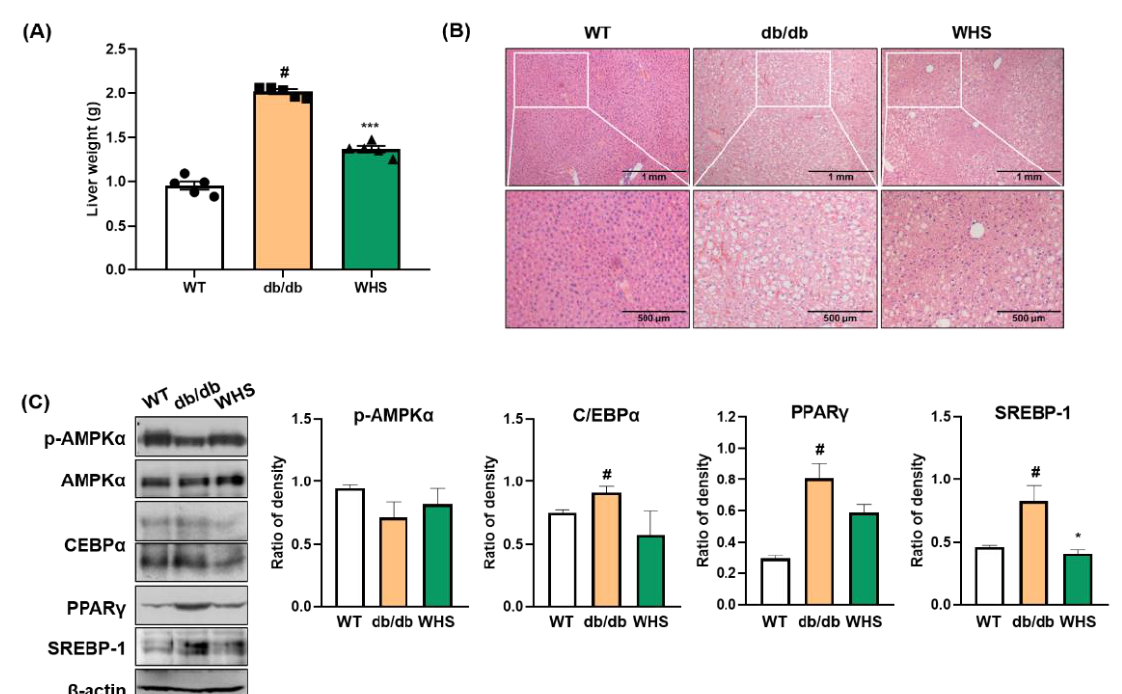
Figure 5. Effect of WHS on adiposity in the liver tissue of db/db mice. ( A ) Liver weight, ( B ) Representative images of H&E-stained liver tissue. ( C ) Total protein was extracted from the liver tissue and western blot analysis was performed to examine the activation of AMPK and the expression of C/EBP α , PPAR γ , and SREBP-1. Values are expressed as the mean ± SEM. # p < 0.05 vs. WT control group; * p < 0.05 and *** p < 0.001 vs. db/db control group.